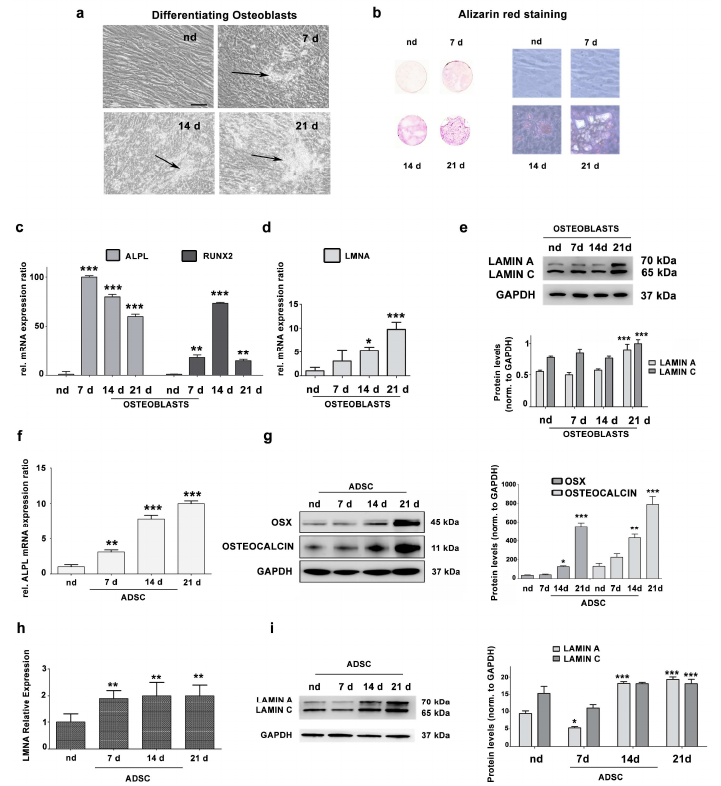
Figure 1. ( a ) Representative images of osteoblasts cultured for 7, 14, 21 days in di ff erentiating medium. nd: cells cultured in DMEM plus 10% FBS for the same time. Arrows indicate hydroxyapatite crystals. Scale bar: 20 µ m. ( b ) Alizarin Red staining of osteoblasts at 7, 14 or 21 days in di ff erentiation medium. nd indicates non-di ff erentiated osteoblasts from a healthy donor, cultured for 21 days in DMEM plus 10% FBS. Left pictures, alizarin red-stained cultures on coverslips imaged by a scanner; right pictures, phase contrast images (20× magnification) of the same cell cultures showing hydroxyapatite crystals. ( c ) Increased ALPL and RUNX2 gene expression by qRT-PCR analysis. Statistical analyses were performed using Student’s t test and asterisks indicate statistically significant di ff erences with respect to nd, ** p < 0.01, *** p < 0.001. ( d ) LMNA gene expression analysis by qRT-PCR in nd